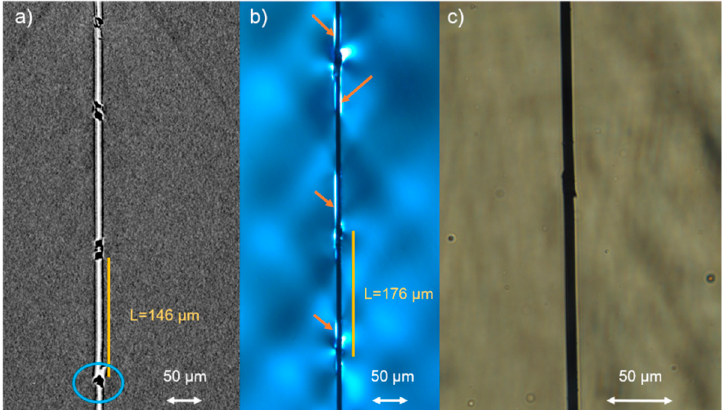
Figure 6. Comparison between visualization of the same preloaded toughened Broutman test specimen using ( a ) XRM, ( b ) polarized light microscopy and ( c ) light microscopy. The measured mean fragment length L for the respective ROI is shown for comparison. The probably debonded areas are marked by the orange arrows.